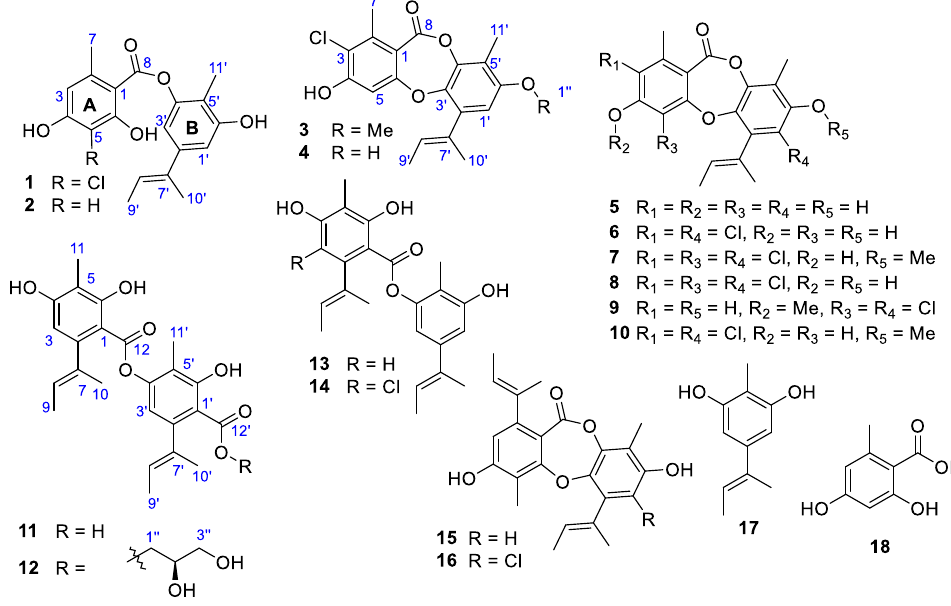
Figure 1. Structures of 1 – 17 isolated from two strains of A. unguis and orsellinic acid ( 18 ). Compound 1 was obtained as a colorless solid. The observed HRESIMS peaks at m/z 385.0819 and 387.0796 [M + Na] + with a ratio of 3:1 determined the molecular formula of 1 as C 19 H 19 ClO 5 (calculated for C 19 H 19 ClO 5 Na, 385.0819, Figure S3), requiring 10 indices of hydrogen deficiency and containing one chlorine atom. The IR spectrum showed double-bond and hydroxy absorption bands at 1621 and 3417 cm − 1 , respectively. The UV spectrum showed absorption bands at 220 and 269 nm, indicating the presence of a benzene chromophore. The 1 H NMR spectrum of 1 revealed eight signals assignable to two meta-coupling aromatic protons at δ H 6.78 (d, J = 1.6, H-1 (cid:48) ) and 6.62 (d, J = 1.6, H-3 (cid:48) ); an aromatic singlet proton at δ H 6.46 (s, H-3); an olefinic proton at δ H 5.86 (m, H-8 (cid:48) ); four methyl groups at δ H 2.61 (s, H 3 -7), 2.00 (s, H 3 -11 (cid:48) ), 1.98 (brs, H 3 -10 (cid:48) ), and 1.77 (dd, J = 6.9, 0.7, H 3 -9 (cid:48) ) (Table 1, Figure S4). The 13 C NMR spectrum of 1 , with the help of the HSQC NMR spectrum, revealed nineteen signals of a carboxyl carbon at δ C 171.4; ten non-protonated sp 2 carbons at δ C 161.9, 159.9, 157.5, 150.8, 144.2, 142.3, 135.9, 116.6, 107.2, and 106.1; four protonated sp 2 carbons at δ C 123.0, 112.4, 111.2, and 110.9; four methyl groups at δ C 9.5 – 24.4 (Table 1,